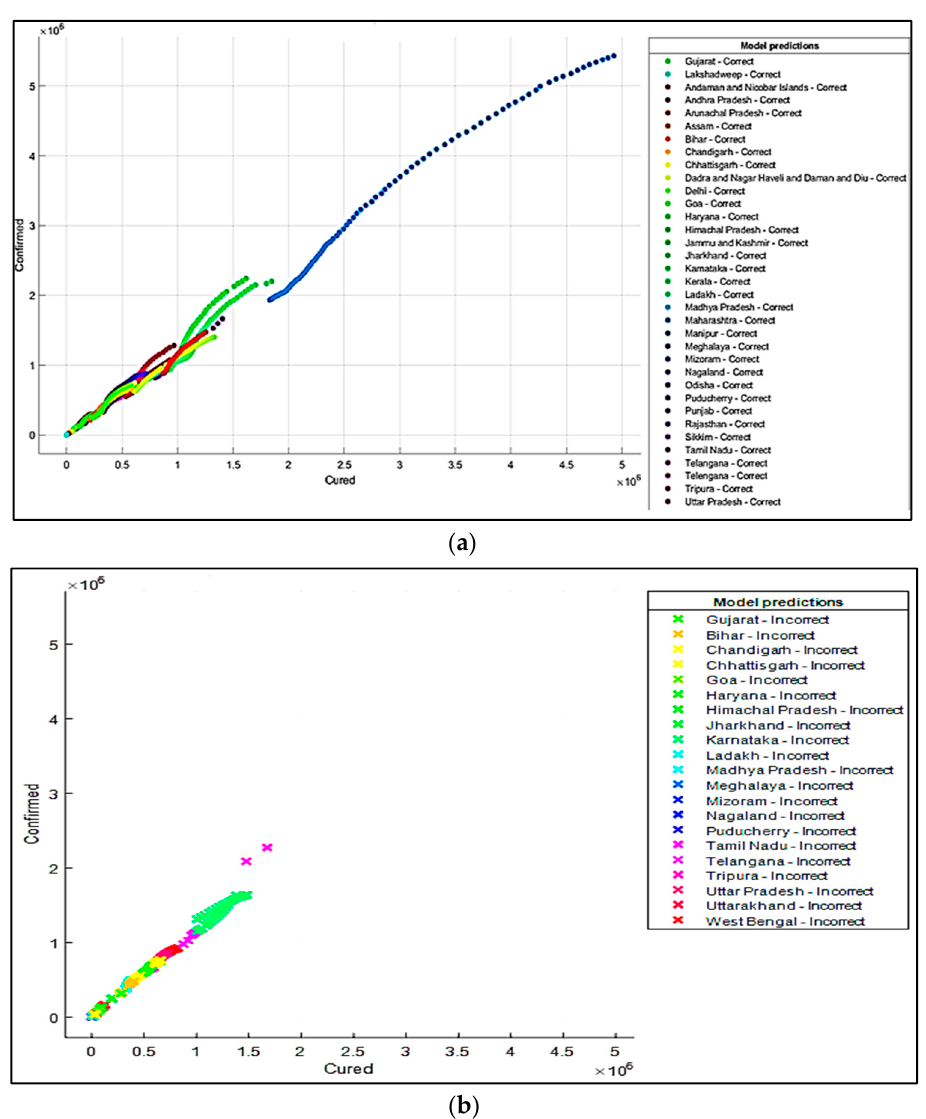
Figure 8. ( a ) Correct Predictions by Gaussian Naïve Model ‘Cured’ vs. ‘Confirmed’. ( b ) Incorrect Predictions by Gaussian Naïve Model ‘Cured’ vs. ‘Confirmed’.